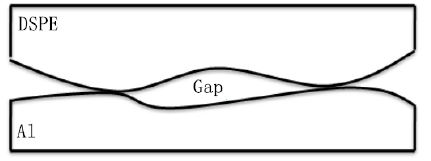
Figure 5. Diagram of the interface contact.